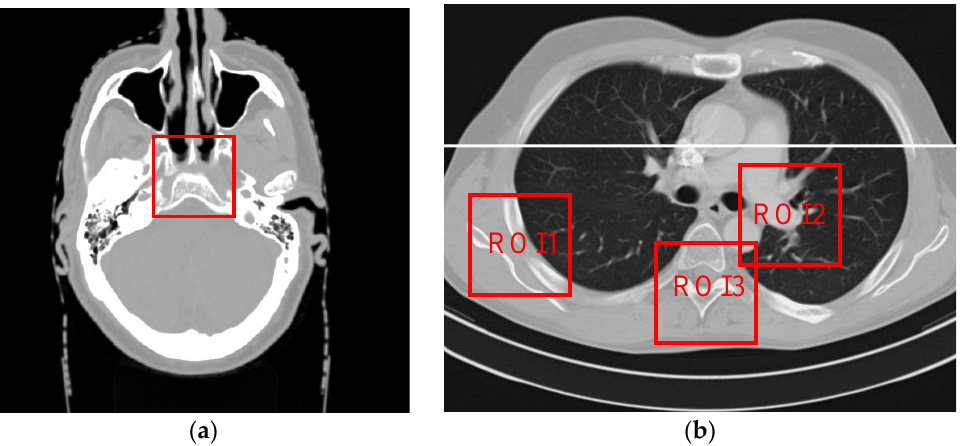
Figure 1. Two phantoms ( a ) brain image phantom; ( b ) Thorax image phantom. The display window is [ − 1000, 667] Hounsfield Unit(HU).